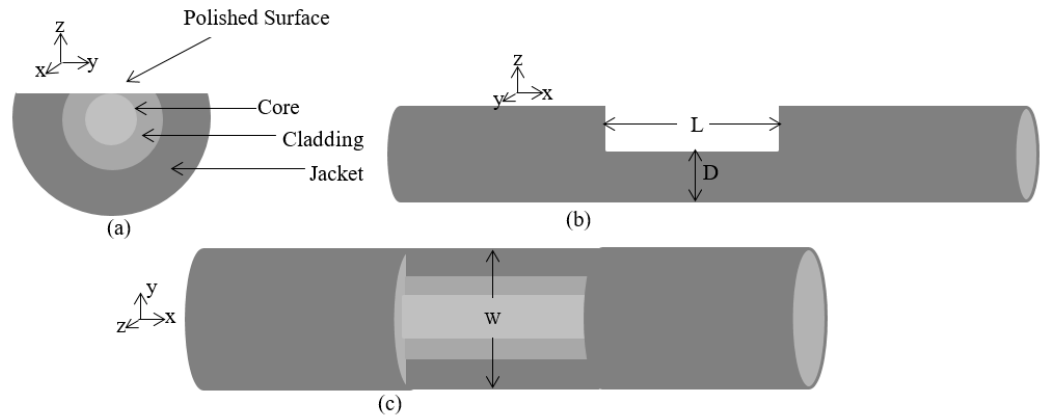
Figure 4. Conceptual illustration of D-sector on PMF: ( a ) Cross-sectional view at Y - Z plane, ( b ) cross-sectional view at X - Z plane and ( c ) cross-sectional view at Y - X plane; L is the length of the polished surface, D is the diameter of the D-sector and W is the width of the D-sector.